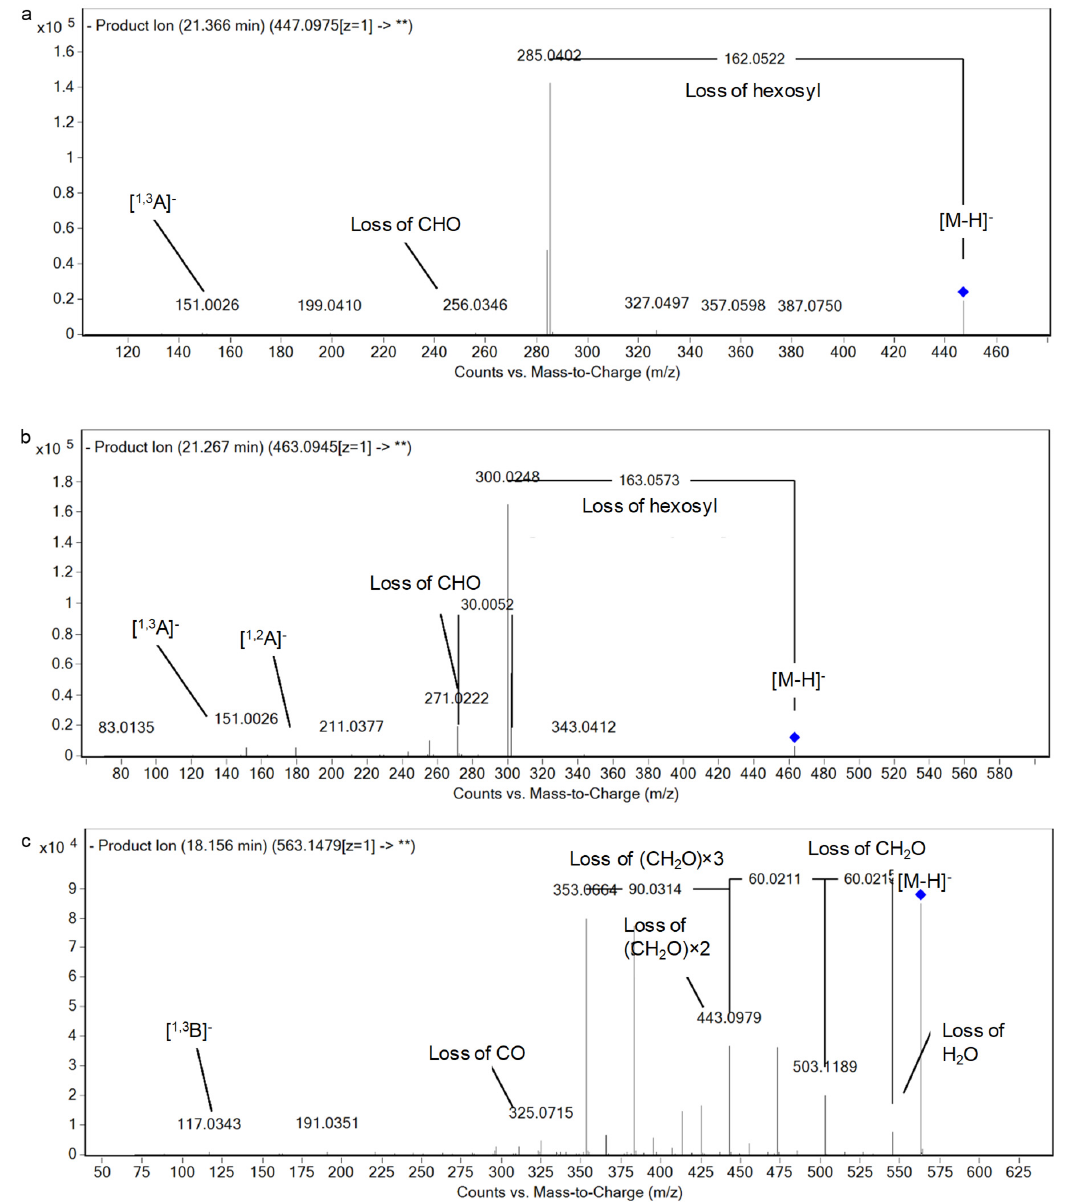
Figure 4. The patterns of fragmentation of ( a ) luteolin 7- O - β -D-glucopyranoside, ( b ) quercetin 3- O - β -D-glucopyranoside, and ( c ) apigenin C -pentoside C-hexoside I.